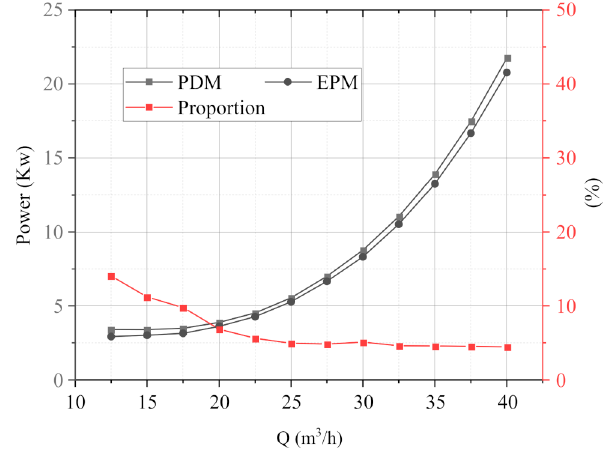
Figure 7. Comparison of calculate methods of total